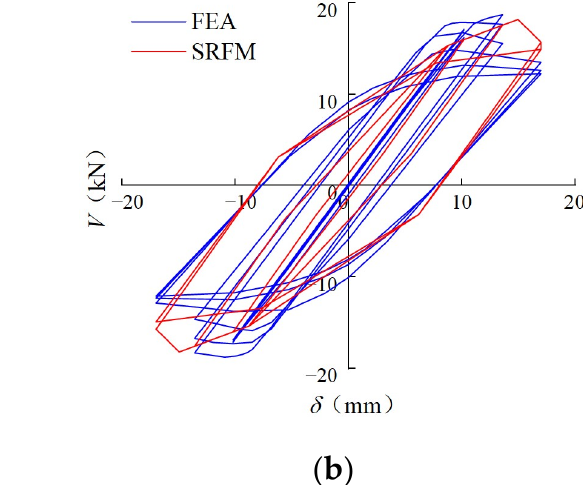
Figure 30. The comparison on the hysteresis curves between FEA model and SRFM for members failed with distortional buckling. ( a ) C3-BC-L30-60-02. ( b ) C3-BC-L30-60-03. 5. The comparison on the hysteresis curves between the proposed SRFM and the FEA model for CFTWS lipped channel members failed with distortional and global cou- pling instability is shown in Figure 31.